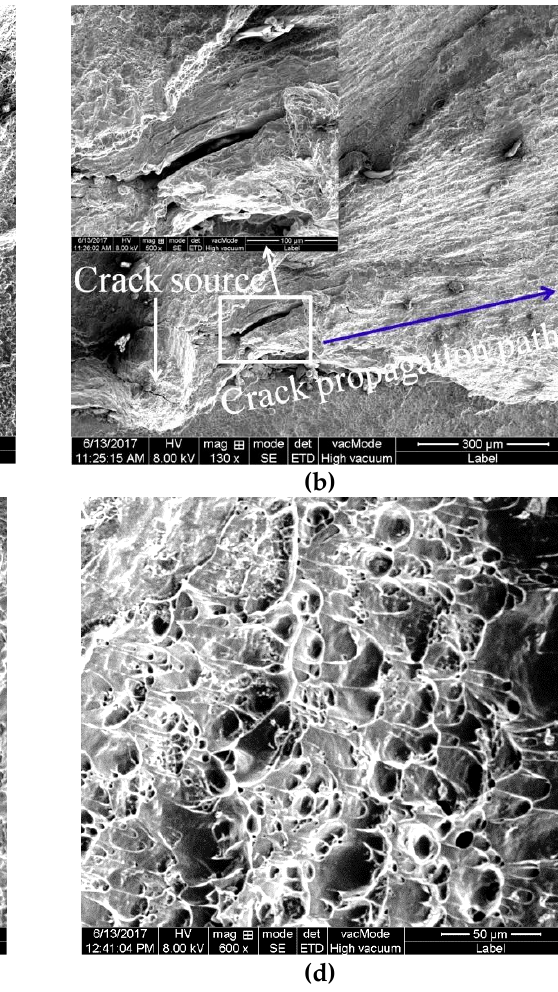
Figure 15. Microscopic fracture morphology of TSZ of dissimilar Al/steel keyhole-free FSSW joint: (a) whole picture, ( b ) brittle–ductile transition, ( c ) brittle cleavage fracture, and ( d ) ductile fracture.